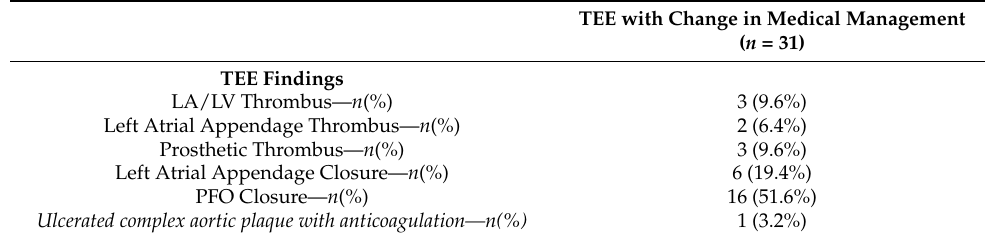
Table 5. Transesophageal Echocardiography Findings with Treatment Change.